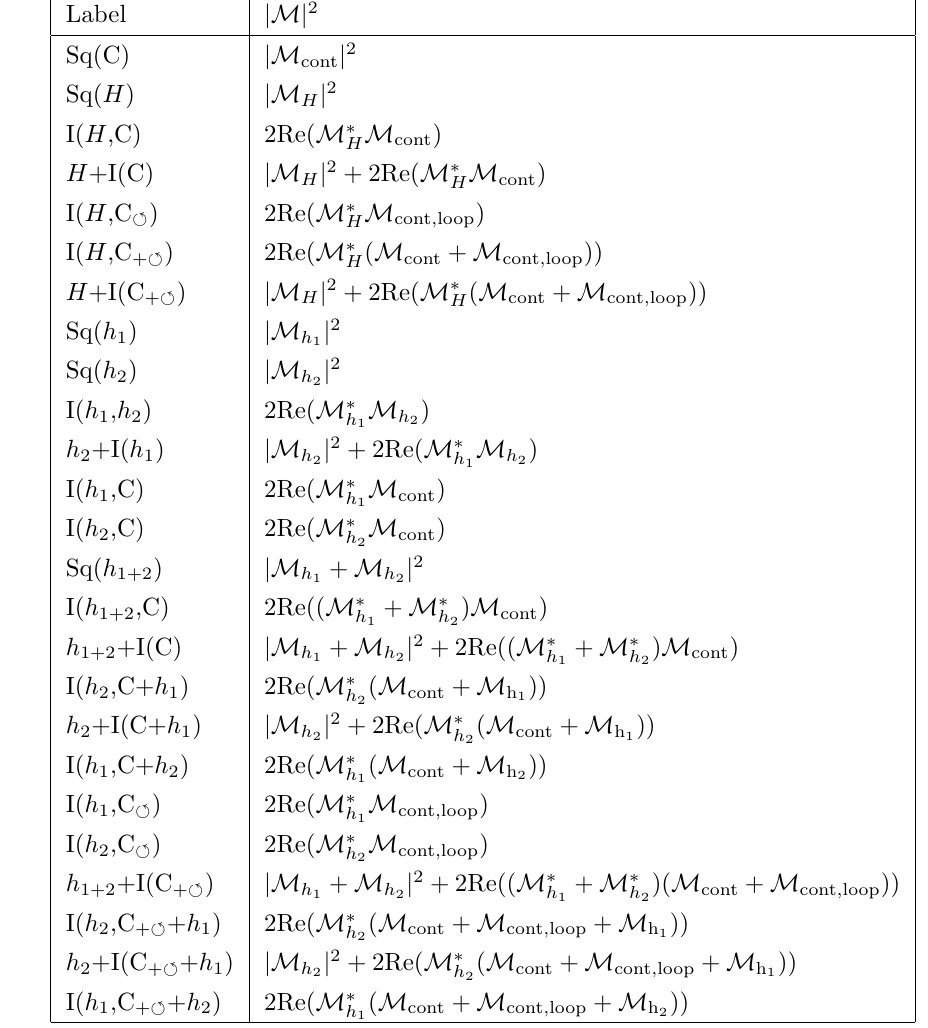
Abbreviations used in tables with integrated cross sections and the corresponding mod-squared amplitude